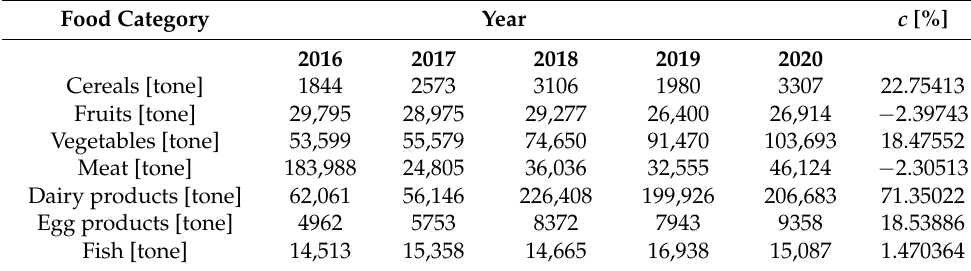
Table 2. Local food supply in Qatar from 2016 to 2022 [36].